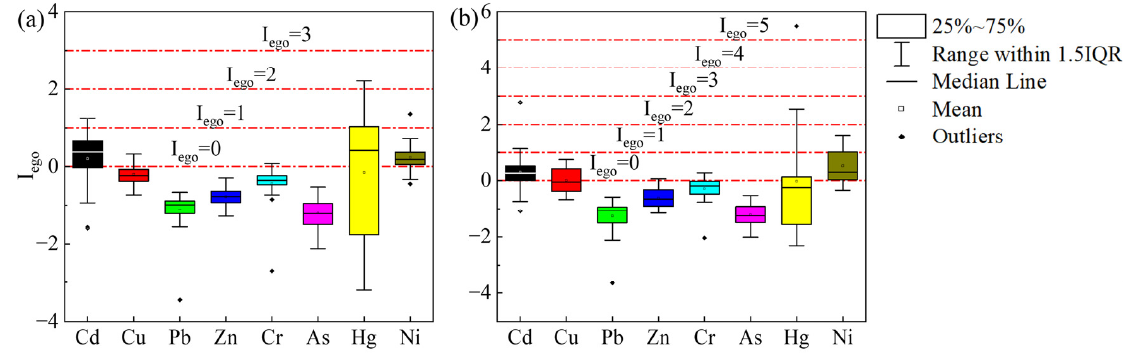
Figure 4. I ego of heavy metal in soil planted with potato ( a ) and hulless oats ( b ) from the Bashang farmland.